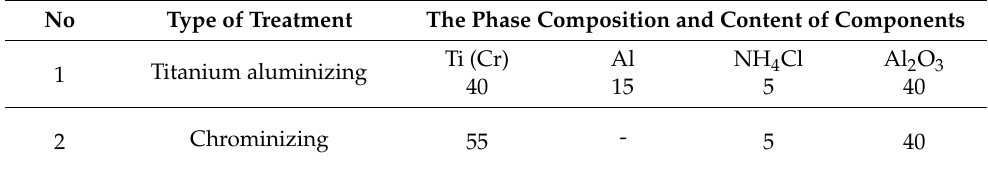
Table 2. Composition of the powder mixture, %